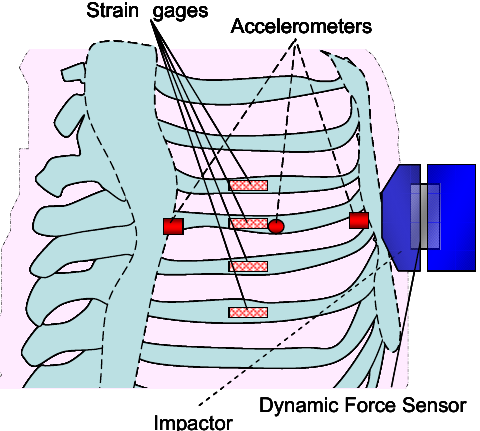
Fig. 3 Geometry of the specimen. The impact height was fixed at the center of the breastbone. Four acceleration sensors were set on the breastbone, thoracic vertebra, the right rib, and left rib, inside the thorax structure. Dynamic force and acceleration sensors were in one plane, which was parallel to the transverse plane. Four strain gauges were bonded to the middle of the 3rd, 4th, 5th, and 6th